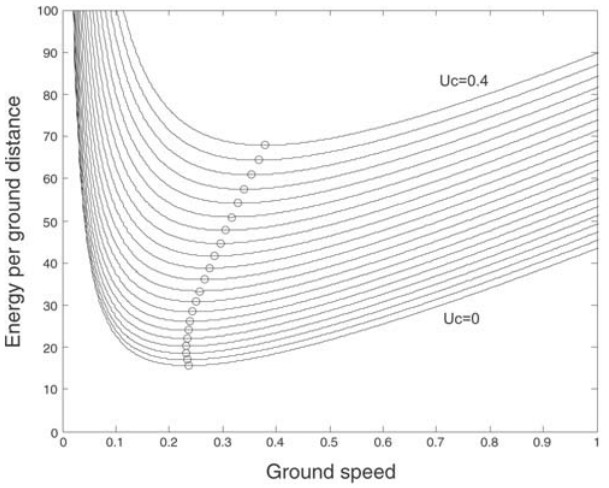
Figure 2. Theoretical predictions on swimming performance of roach (17.0 cm; 55.5 g) swimming at 4.9 u C. Energy use as a function of ground speed at different head current velocities in steps of 0.02 ms 2 1 (U c= 0 for lowest curve; U c= 0.4 for highest curve). Circles indicate optimal ground speed at a given current velocity.